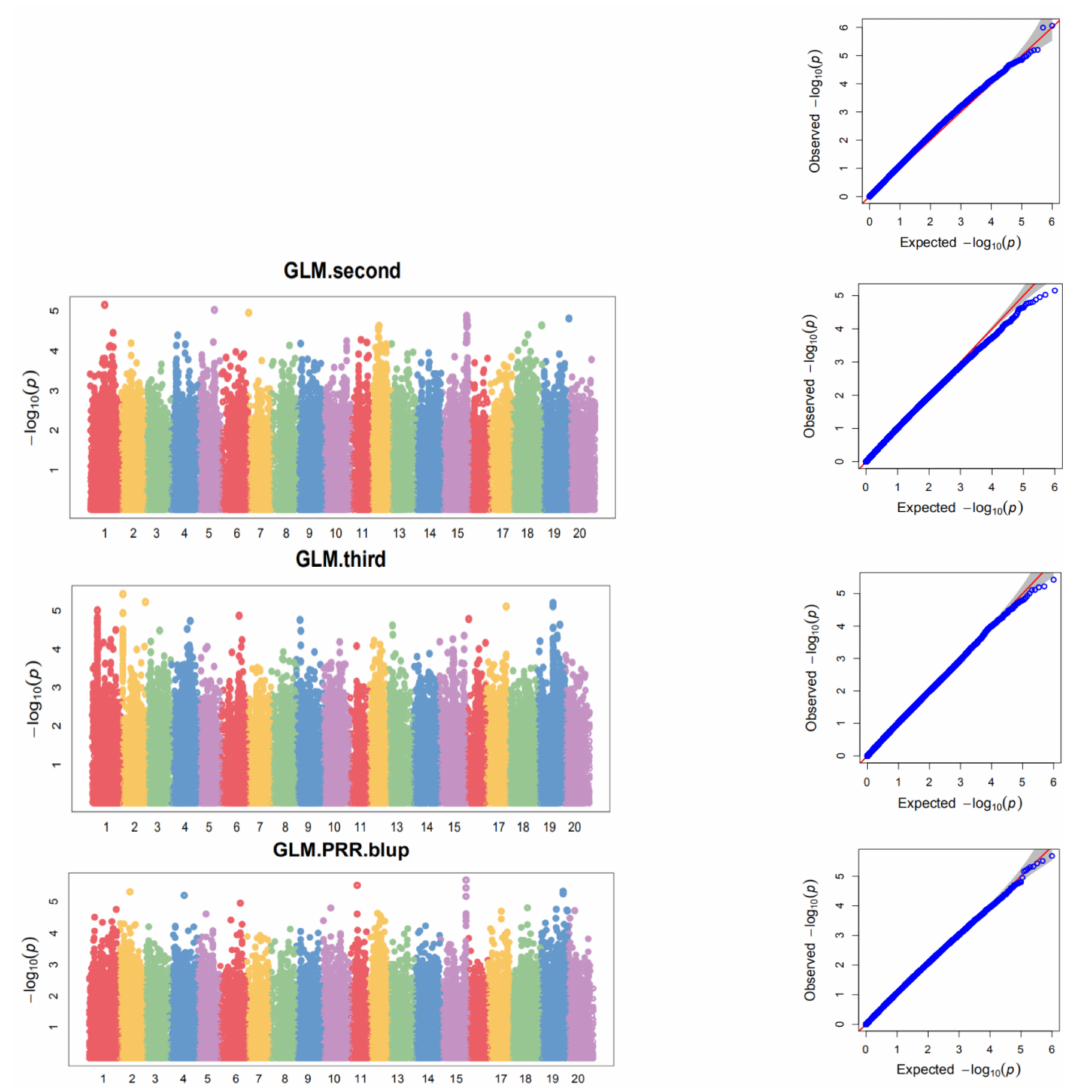
Figure 6. Manhattan and QQ plots of GWAS for wild soybeans resistance to